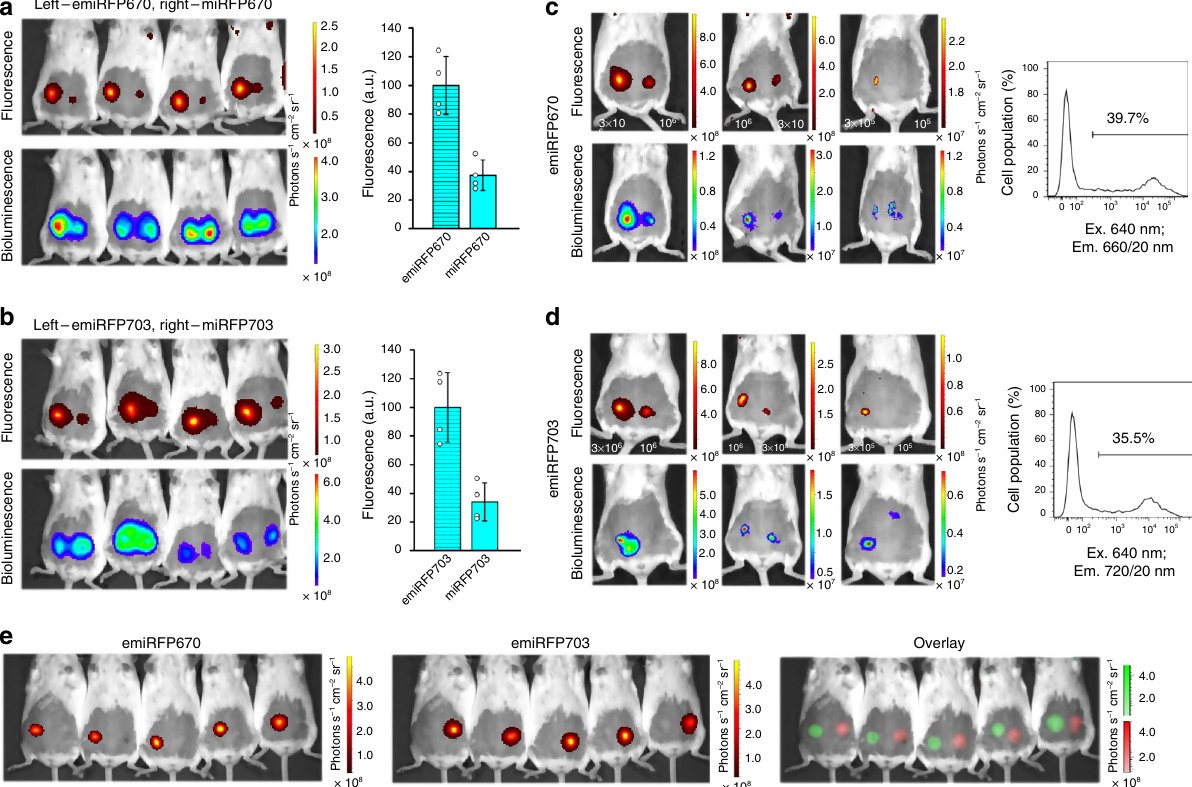
Fig. 7 Performance of emiRFPs in vivo. a , b Comparison of emiRFP670 with parental miRFP670 ( a ) and emiRFP703 with parental miRFP703 ( b ). Fluorescence (top row) and bioluminescence (bottom row) images of living mice injected with 3 × 10 6 COS-1 cells expressing emiRFP670 or emiRFP703 (left) and miRFP670 or miRFP703 (right). Cells were co-transfected with Rluc8. The fi lter sets were 640/20 nm excitation and 680/30 nm emission ( a ) or 675/20 nm excitation and 720/30nm emission ( b ). Bar plots at the right show quanti fi ed mean fl uorescence intensities (normalized to bioluminescence) that correspond to a and b . Error bars, double s.e.m. ( n = 3 experiments). c , d Minimal number of detectable fl uorescent cells. Fluorescence (top row) and bioluminescence (bottom row) images of living mice injected with various quantities of COS-1 cells expressing emiRFP670 ( c ) or emiRFP703 ( d ) and co- transfected with Rluc8. The fi lter sets were 640/20nm excitation and 680/30 nm emission ( c ) or 675/20 nm excitation and 720/30nm emission ( d ). Transfection ef fi ciency of injected COS-1 cells obtained by FACS analysis shown on the right of each panel. e Two-color imaging of emiRFP670 and emiRFP703. Fluorescence images of living mice injected with 3 × 10 6 COS-1 cells expressing emiRFP670 (left row) and emiRFP703 (middle row) and its unmixed overlay (bottom row) are shown. Images were acquired in 19 spectral channels using IVIS Spectrum instrument and spectrally